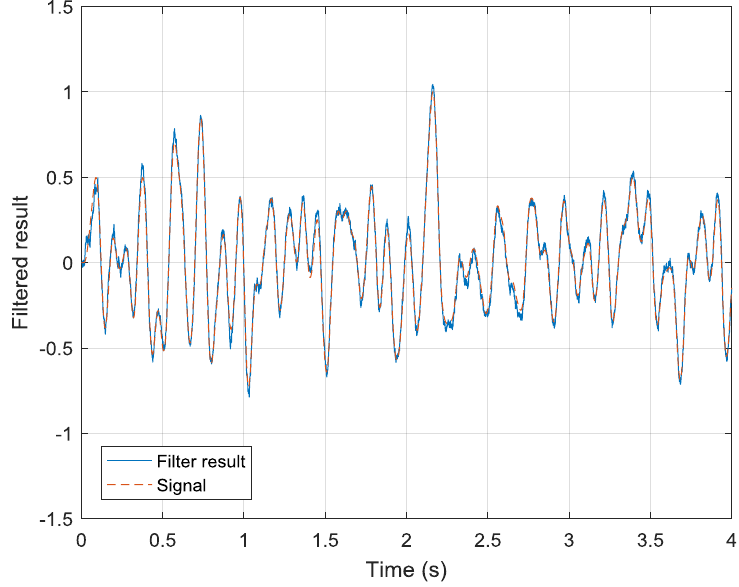
Figure 7. Simulation of the linear-prediction-based Kalman filter.